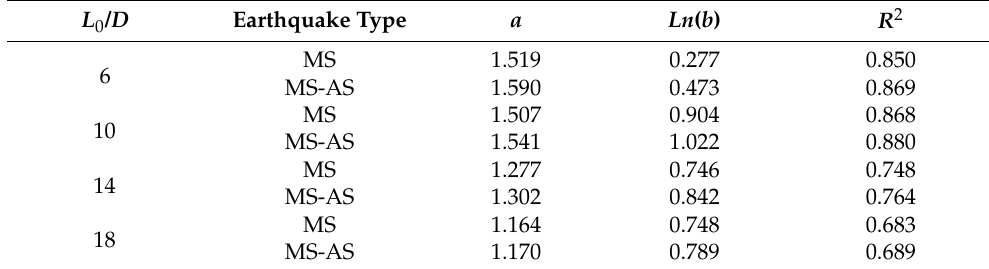
Table 7. Linear fitting equation of the columns.